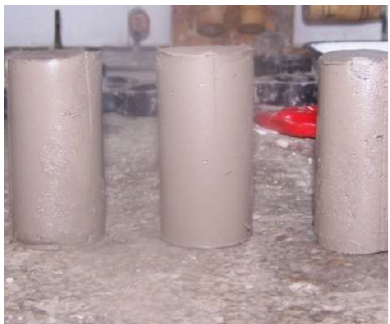
Figure 2. Sample after demolding.